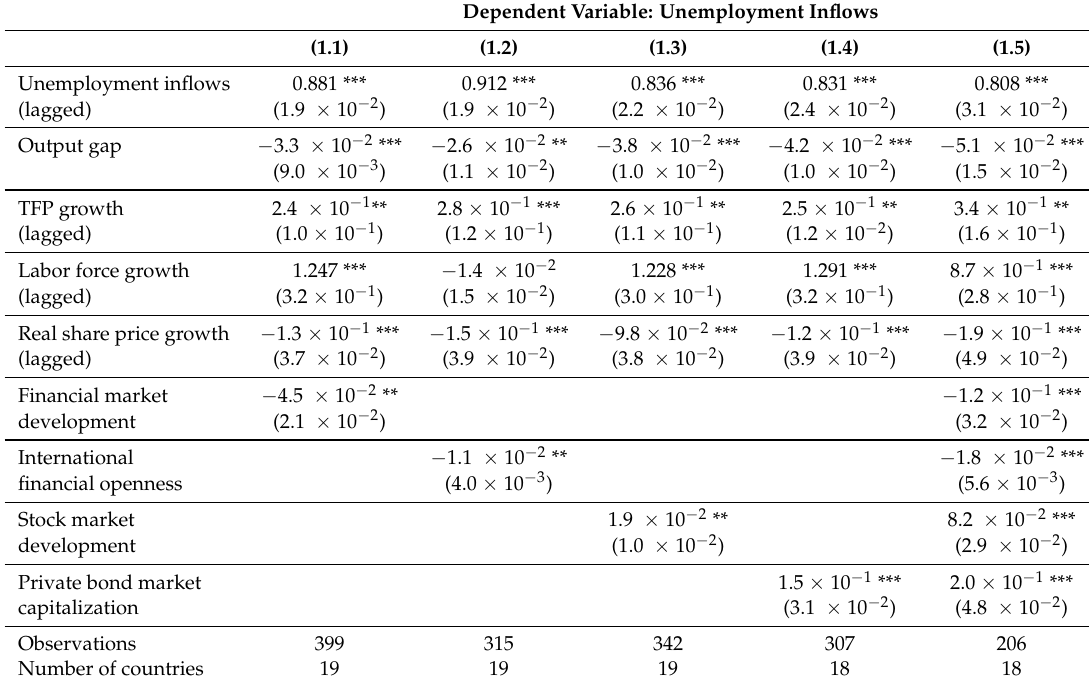
Table 1. Financial market determinants of unemployment